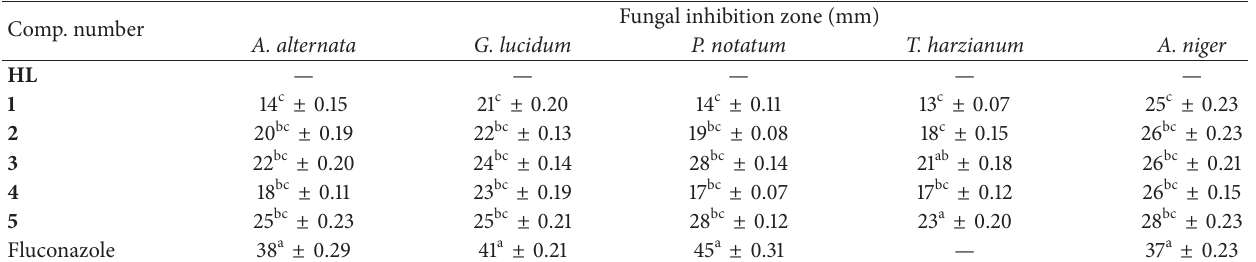
Table 11: Antifungal activity data a,b of organotin complexes 1–5 .